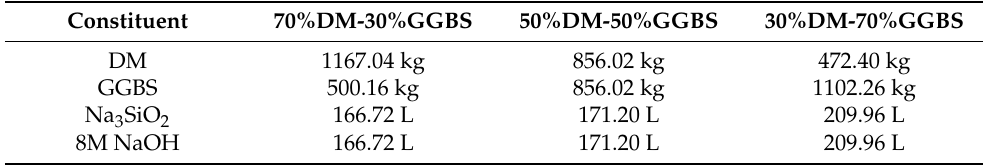
Table 3. Constituent Content per 1 m 3 Mixture (3 Mix